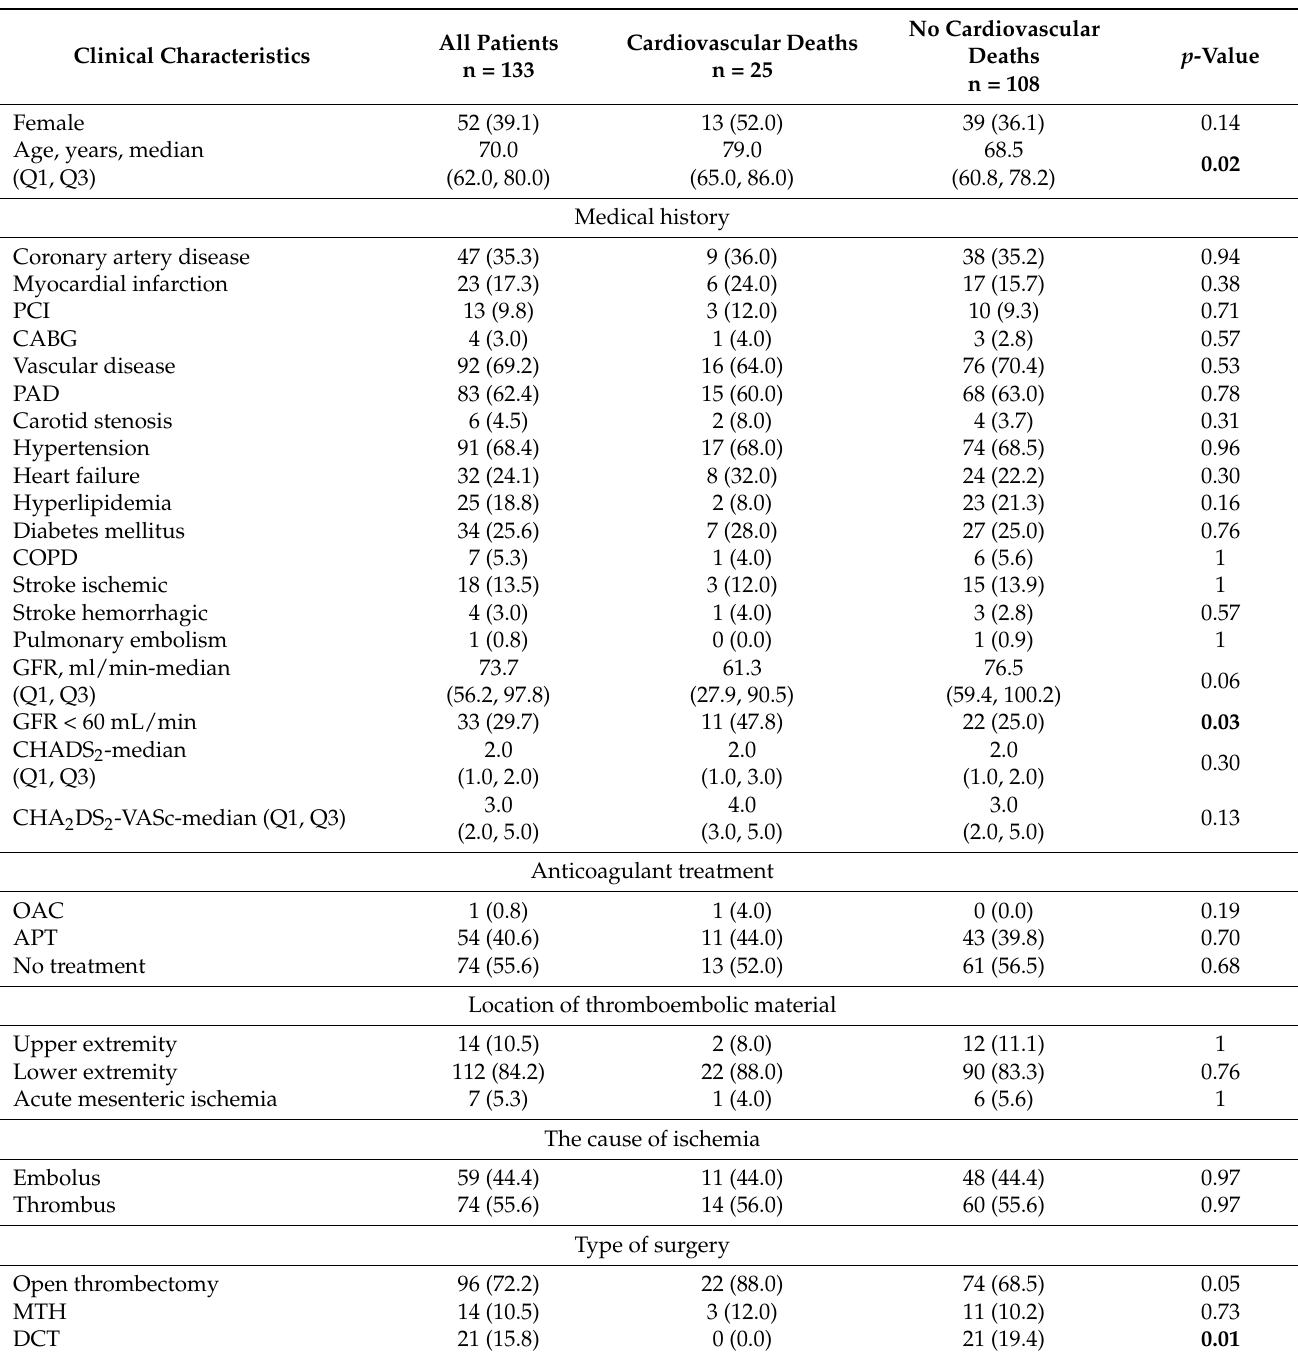
Table 4. The comparison of patients with sinus rhythm who died of cardiovascular causes with those who did not die of such